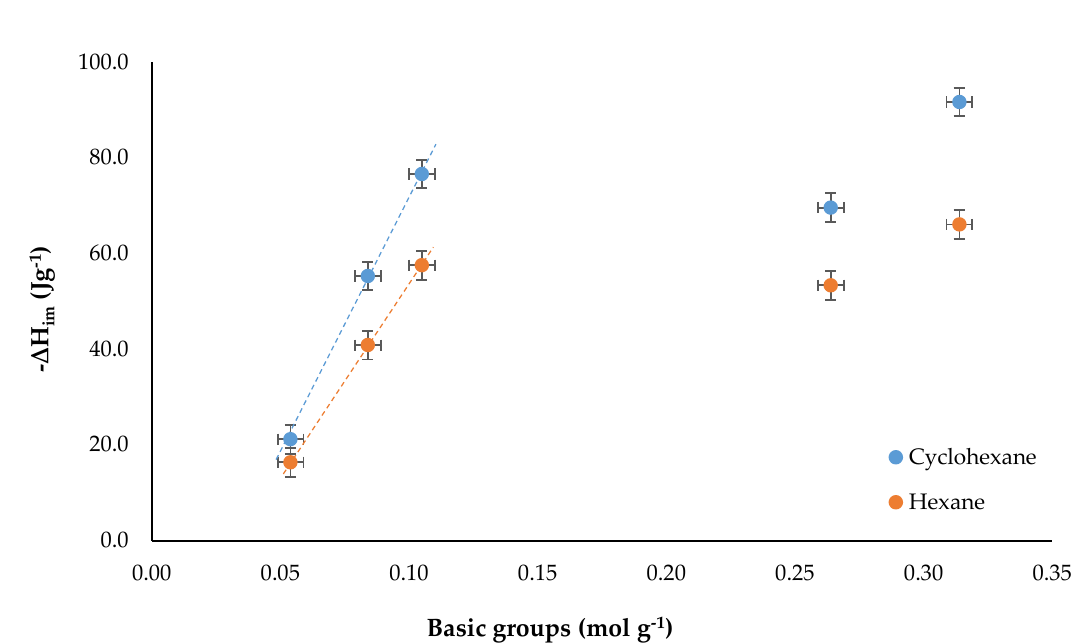
Figure 6. Immersion enthalpy in function of the total basic groups content.